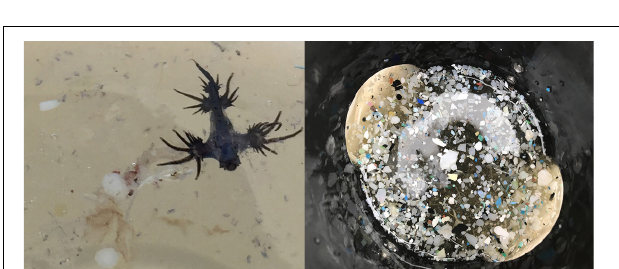
FIGURE 5 | Example of freshly collected neuston, plankton and plastic by the HSN and Manta net. (Left) Half of a daytime HSN collector content diluted in 1 L of seawater during the Japan – Hawaii leg. The pictured organism is a mollusk Glaucus sp., the blue dots are Pontelida e copepods and the white particles are microplastic. (Right) Microplastics in the collector of a Manta net deployed in the Great Pacific Garbage Patch. (Photos F. Lombard and M. L.